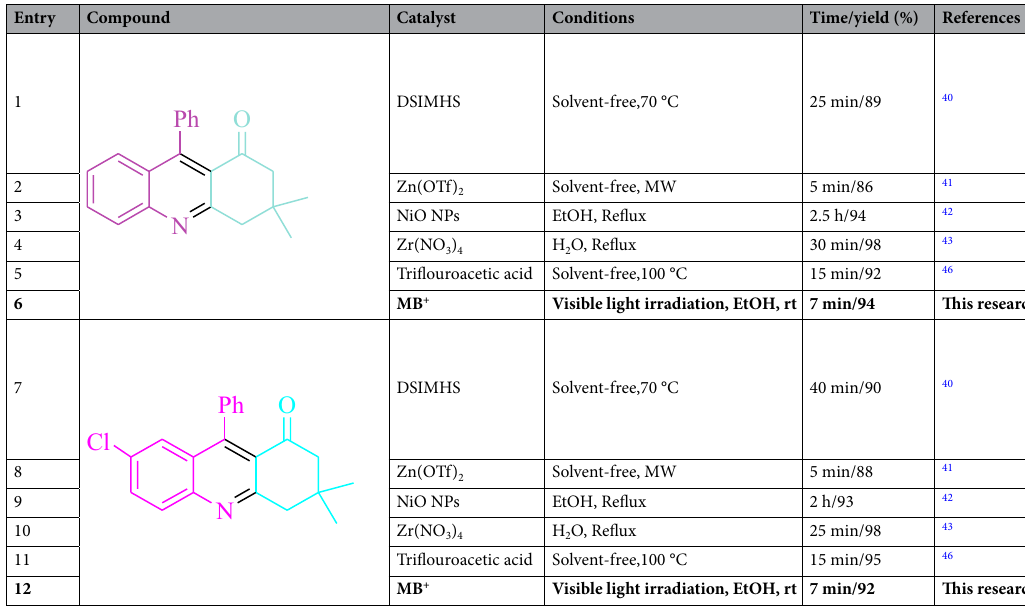
Table 5. Comparison of the catalytic ability of some of the catalysts in the manuscript to produce 3a , 3b. Reaction conditions: 2-aminobenzophenone/5-chloro-2-aminobenzophenone and